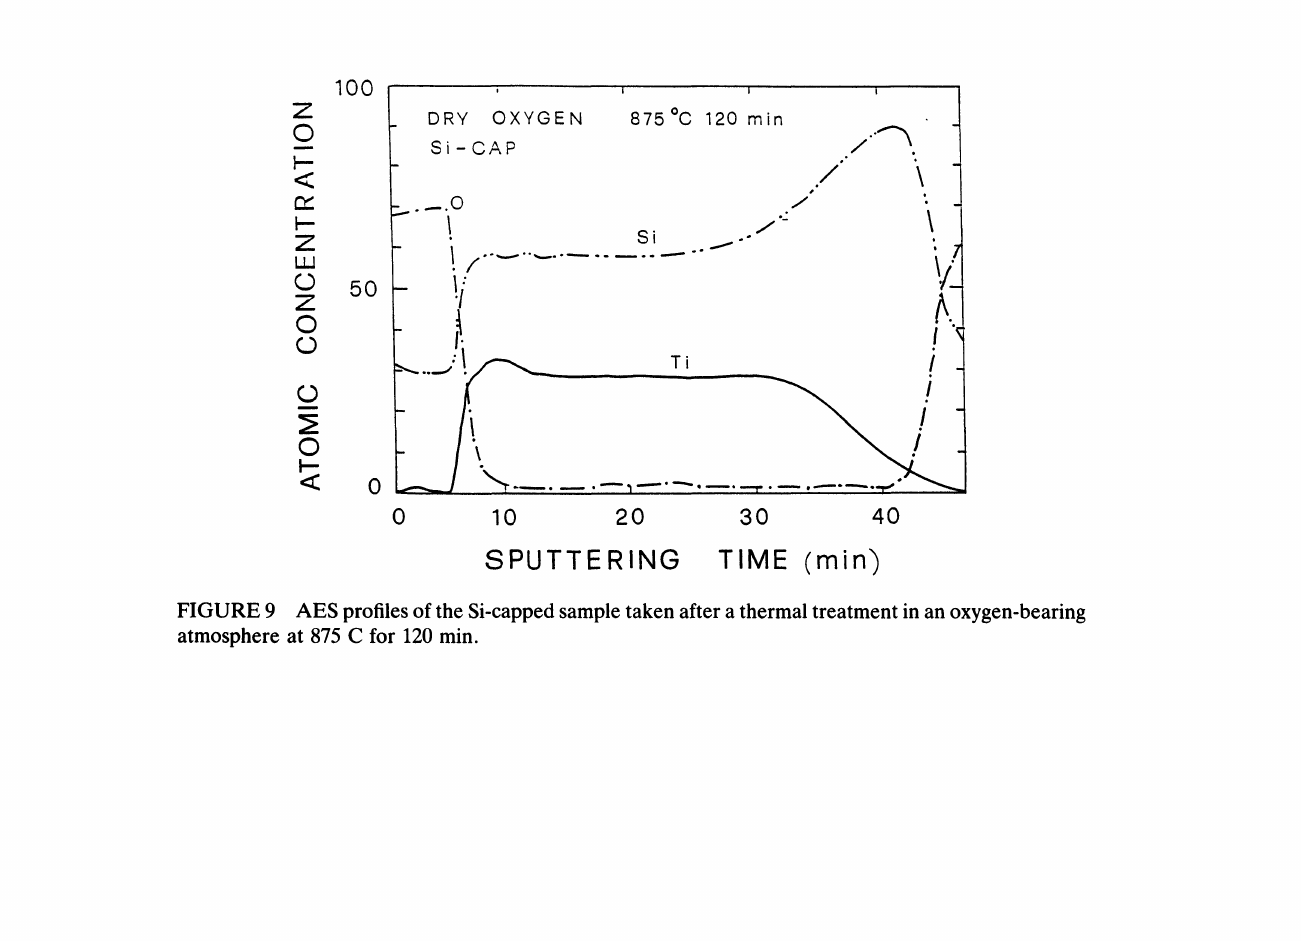
FIGURE 9 AES profiles of the Si-capped sample taken after a thermal treatment in an oxygen-bearing atmosphere at 875 C for 120